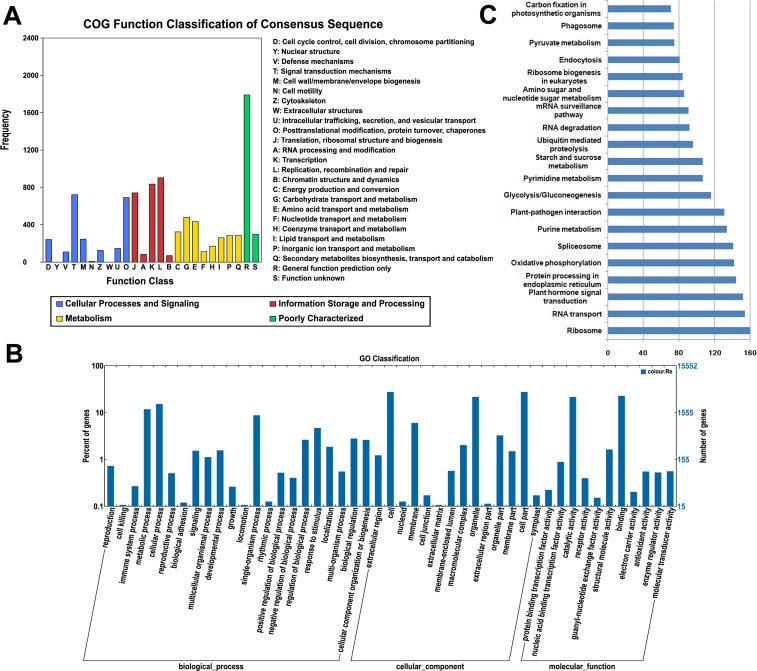
The classification of colored calla lily ‘Rehmannii’ unigenes.(A) Distribution of Cluster of Orthologous Group (COG) classification. A total of 6,731 assembled unigenes were annotated and assigned to 24 functional categories. The x-axis indicates the subgroups in the COG classification while the y-axis indicates the number of genes in each main category. (B) Gene ontology (GO) classification of assembled unigenes at level 2. A total of 15,552 unigenes were grouped into three main GO categories: ‘Biological Processes’, ‘Cellular Component’, and ‘Molecular Function’. The x-axis indicates the subgroups in GO annotation while the y-axis indicates the percentage of specific categories of genes in each main category. (C) The top 20 KEGG metabolic pathways of assembled unigenes. The x-axis indicates the number of genes in each metabolic pathway while the y-axis indicates the subgroups in the top 20 KEGG metabolic pathways.